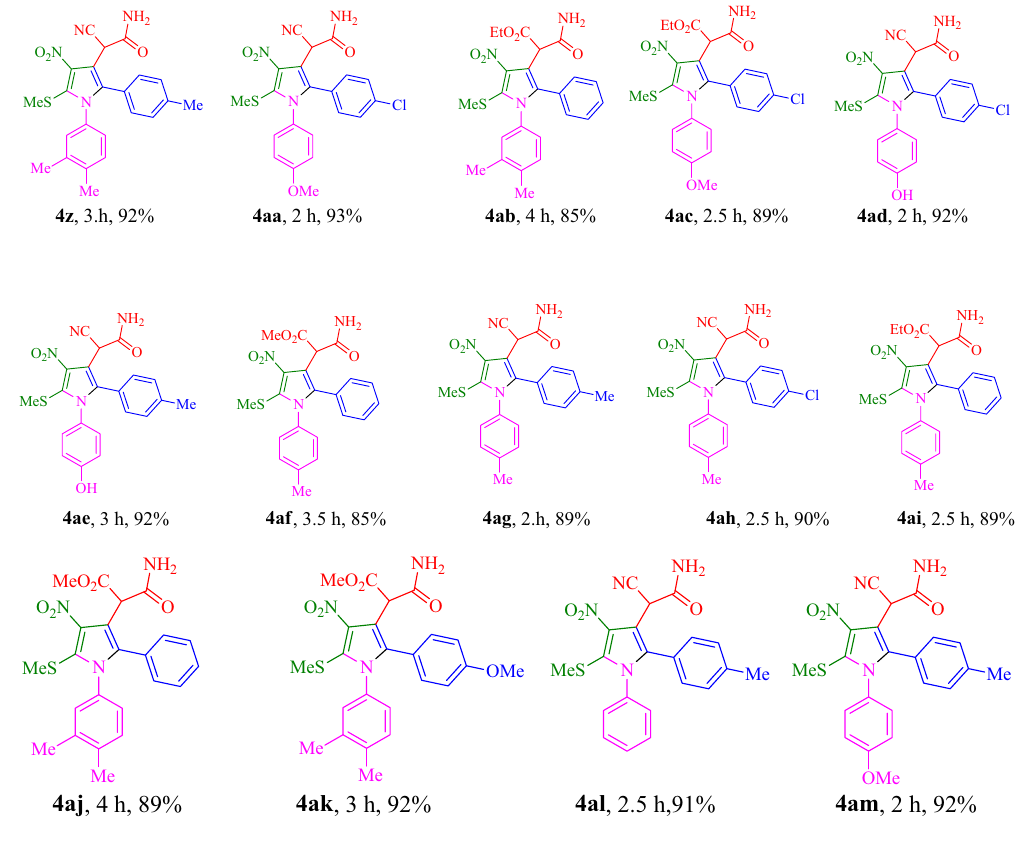
Table 1. Multicomponent synthesis of polysubstituted pyrrole derivatives a,b . a Isolated yield. b